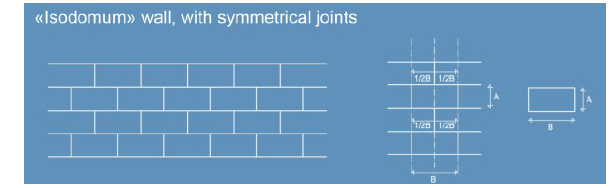
Figure 2. The opus parameters